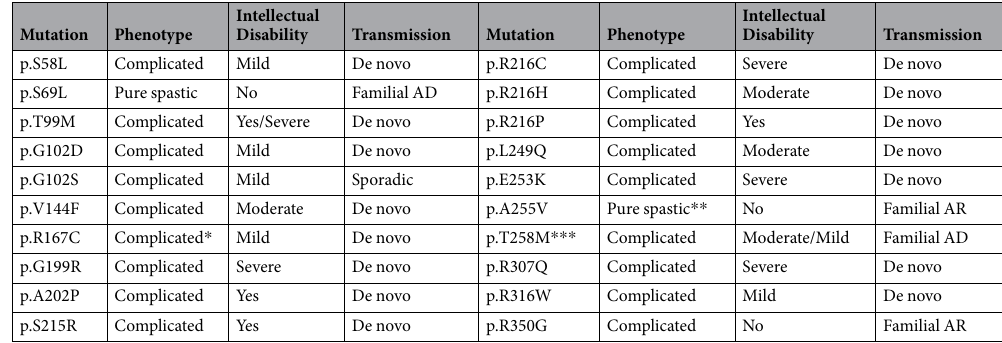
Table 2. Clinical phenotypes and inheritance patterns of patients with various missense mutations in the motor domain of KIF1A . * Another case of pure form reported 15,23 . ** Another case of complicated form reported 20,21 . *** New mutation identified in this